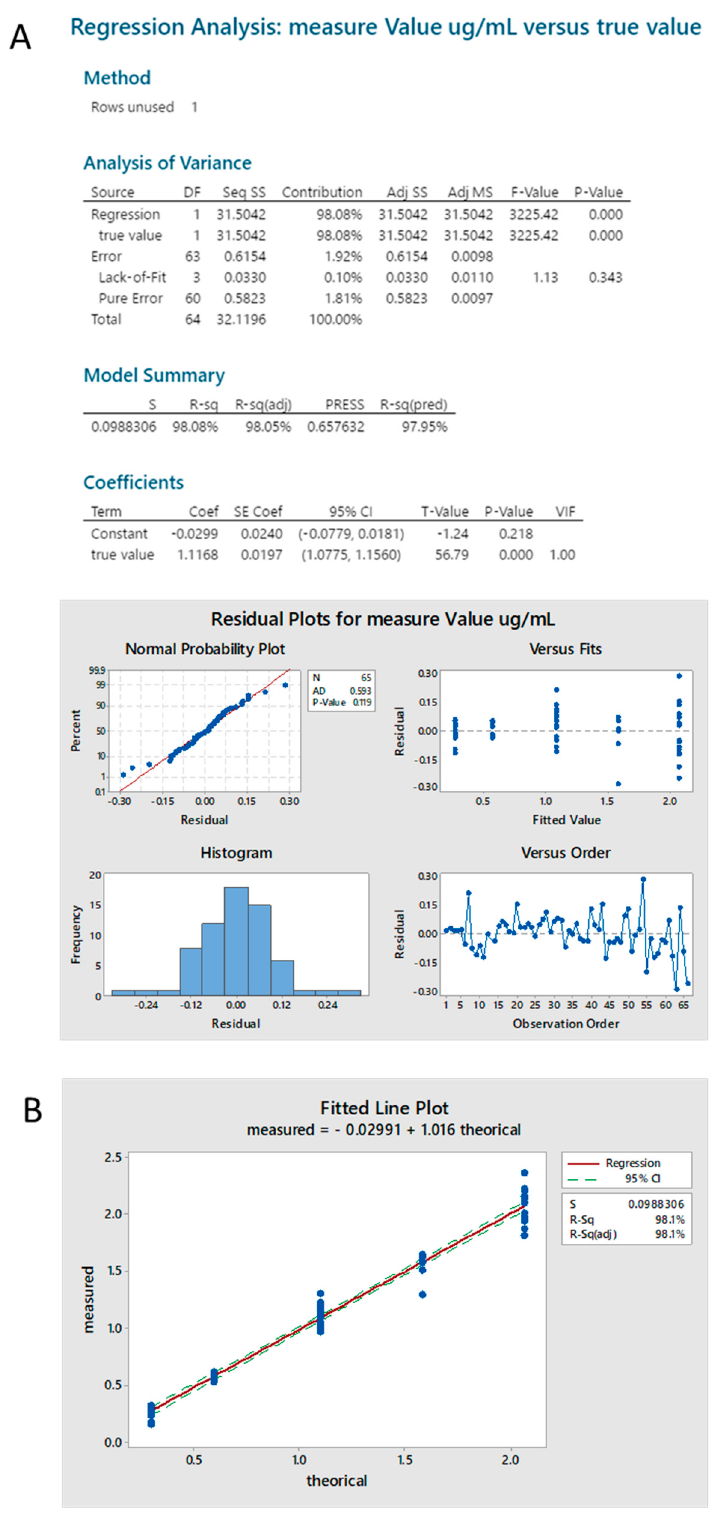
Figure A5. Sample Linearity determination for quantification of S. flexneri 6 OAg with Dische colorimetric method: ( A ) ANOVA on 5 replicates for the calibration curve; ( B ) calibration curve plot.